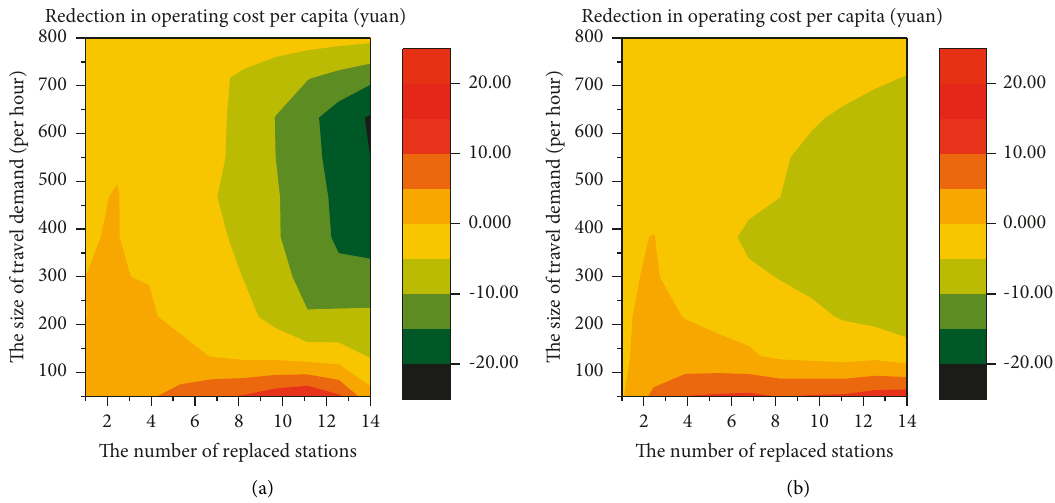
Figure 7: The reductions in the operating cost per capita in (a) integrated operation mode I and (b) integrated operation mode II. Table 4: The optimal bus operation plans with different travel demands.